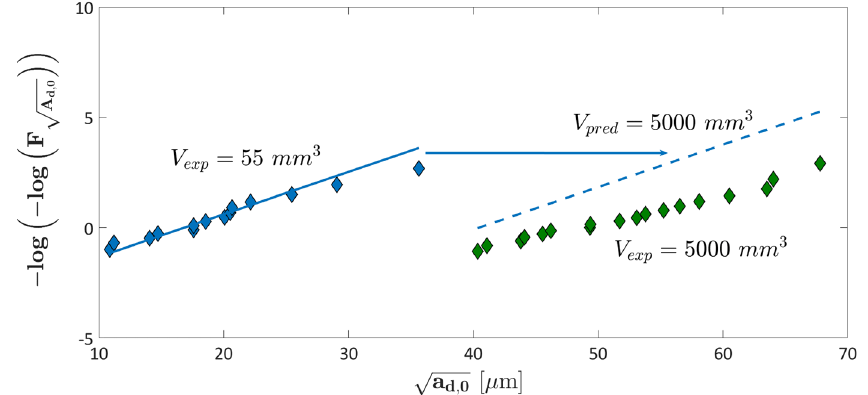
Figure 9. Gumbel plot of the defect size for hourglass specimens (blue points are experimental values; the solid blue curve is the estimated LEVD) and Gaussian specimens (green points are experimental values; the dashed blue curve is the estimated LEVD from hourglass data).